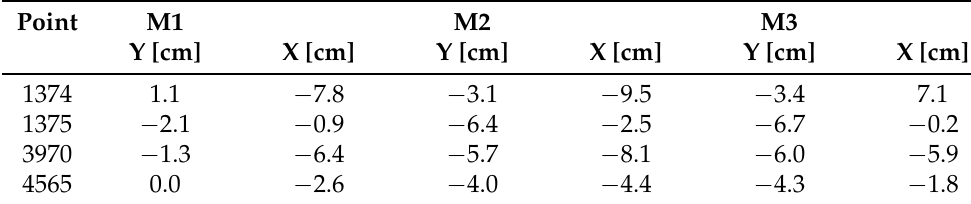
Table 6. Results of the different methods using the control points originally used: M1 (local trans- formation by 2D Helmert transformation), M2 (IDW based on residuals), and M3 (IDW based on homogeneous vectors).